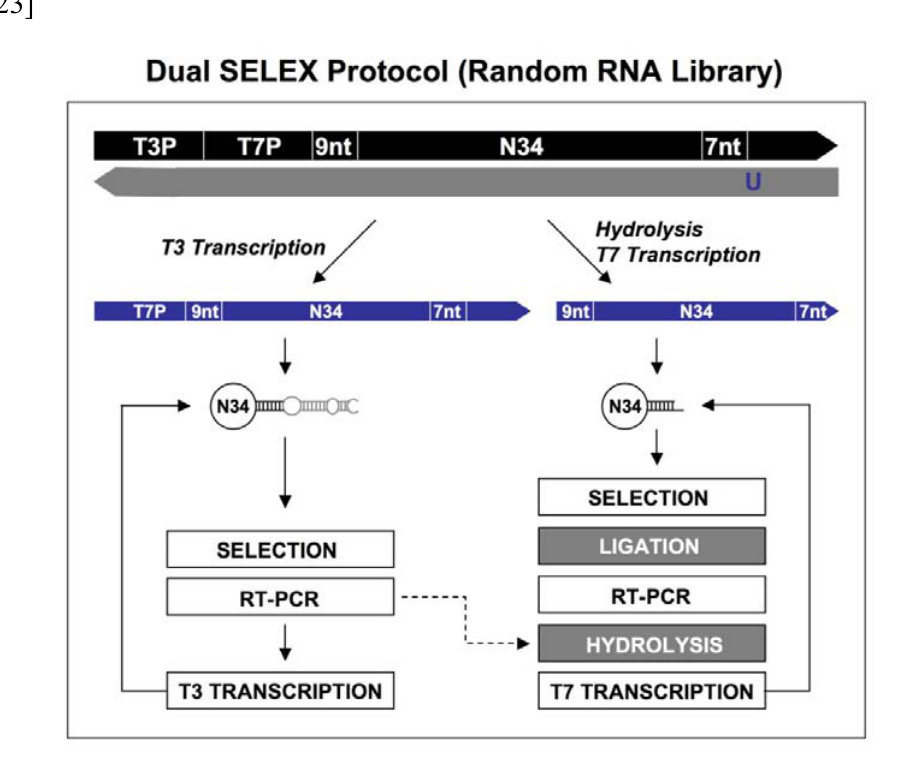
Figure 6 . Diagram of dual SELEX. Tandem promoter sequences for T3 and T7 RNA polymerases are located at the 5' end of the library. The integration of the reverse primer that contains ribose (blue U), introduces the cleavage sites for alkaline hydrolysis of the template. The full-length RNA library is transcribed by T3 RNA polymerase, and the short RNA library is generated by using T7 RNA polymerase and the alkaline-hydrolyzed templates. The templates of the PCR products are shared templates that can be switched, commonly after a few rounds of full-length RNA library selection, which can be switched to short RNA library selection as the dashed arrow indicated. This protocol is from Jarosch et al.